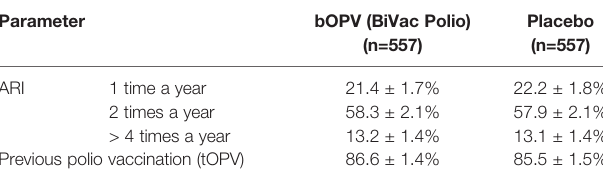
TABLE 3 | Incidence of prior acute respiratory infections (ARI) and polio vaccination status among study participants based on questionnaire responses. Parameter